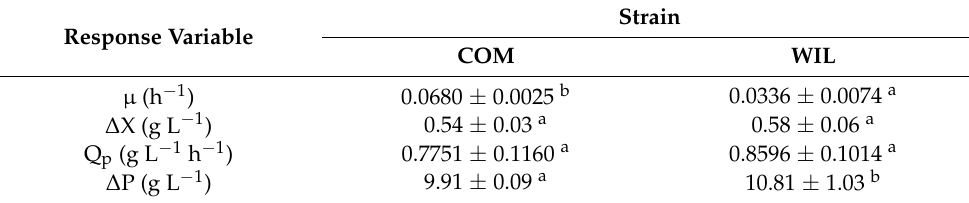
Table 2. Growth and lactic acid production kinetic parameters in Habanero pepper